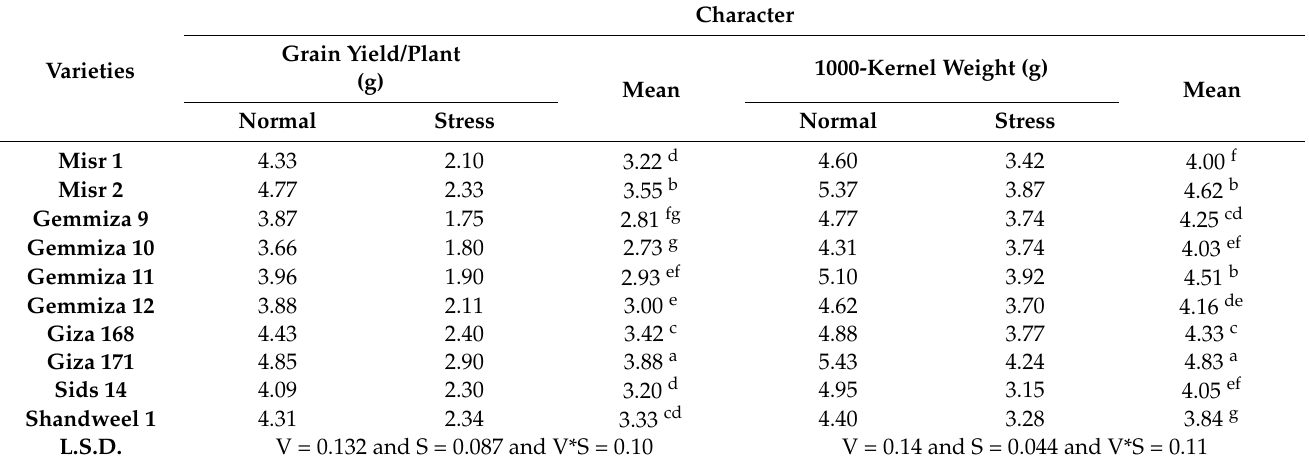
Table 4. Mean values of grain yield weight/plant and 1000-kernel weight traits for ten wheat cultivars under normal and stress conditions. Different letters are significantly different, according to the LSD test, at p <